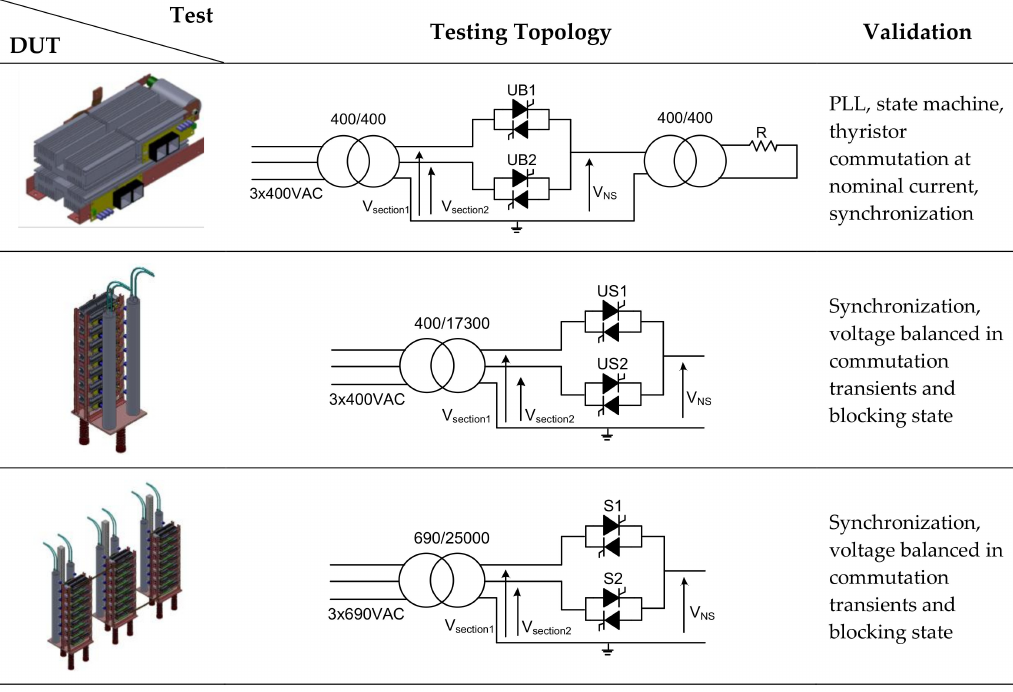
Figure 7. Application conditions for the test procedure of AC static switch. PLL, phased locked loop. DUT, device under test.